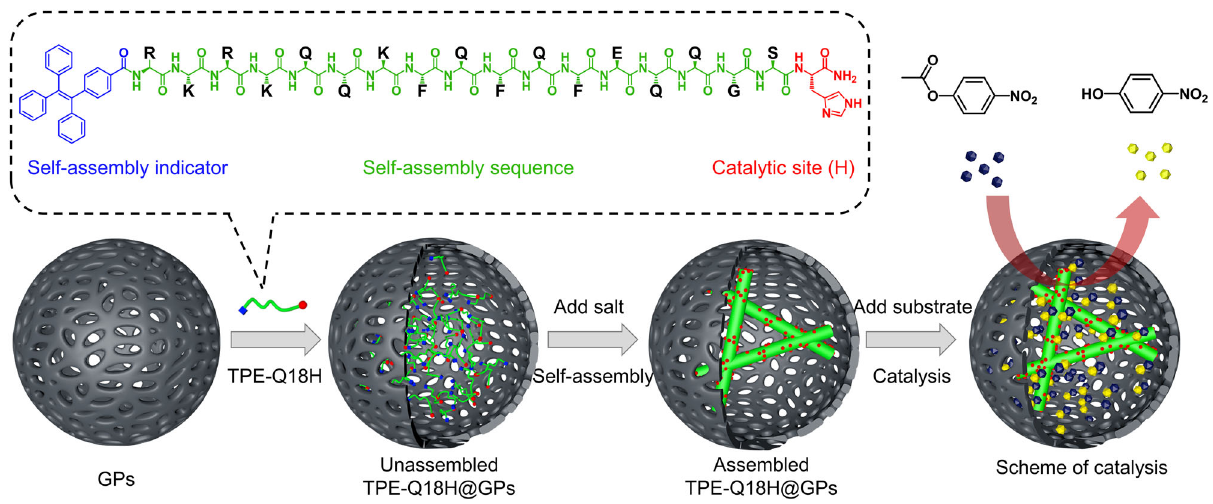
Fig. 1 Illustration of temporal and spatial controlled GPs-based enzymatic compartments. The catalytic peptide (TPE-Q18H) was assembled in GPs by regulating the ionic strength and promoting the ester hydrolysis reaction with a higher catalytic ef fi